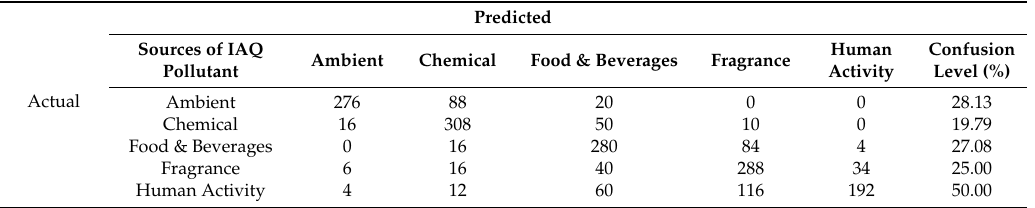
Table 10. Confusion matrix of multilayer perceptron (MLP) for sensor normalization (SN) after principal component analysis (PCA).